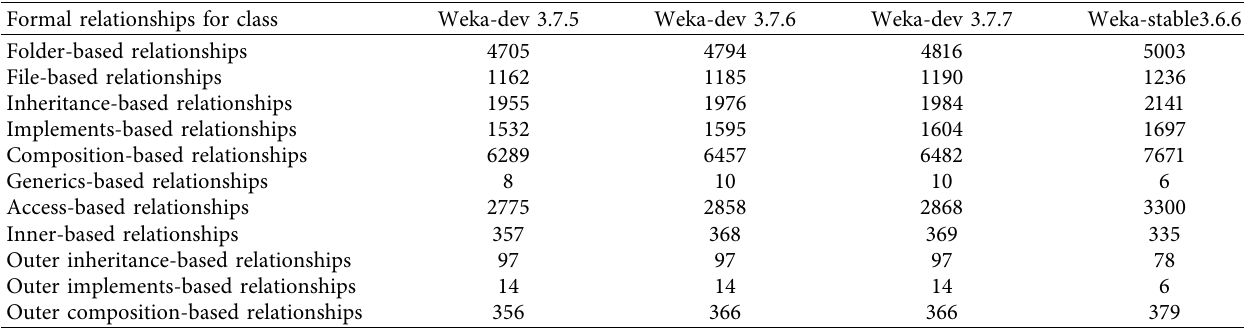
Table 24: Formal relationships for class in weka.